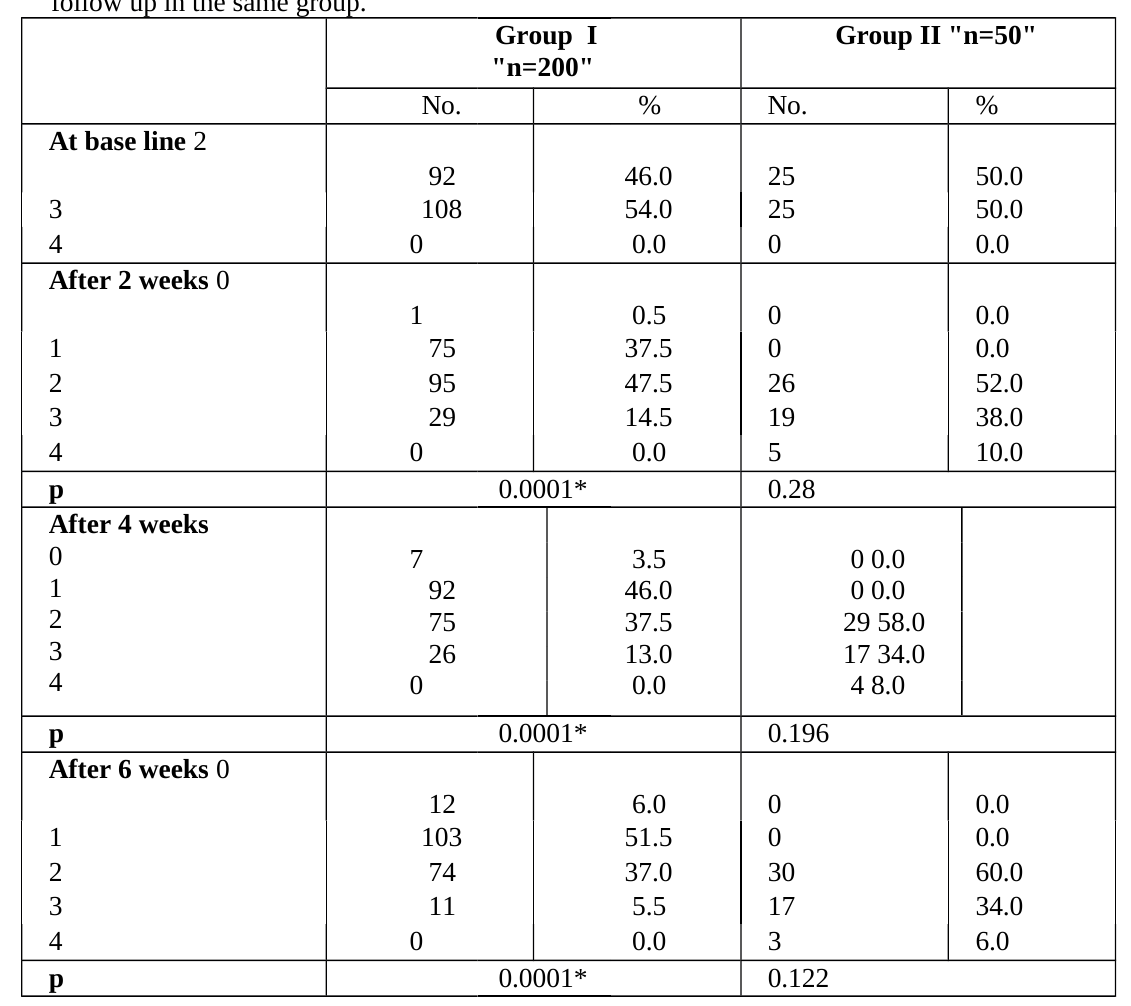
Table (8): Comparison between the two studied groups regarding